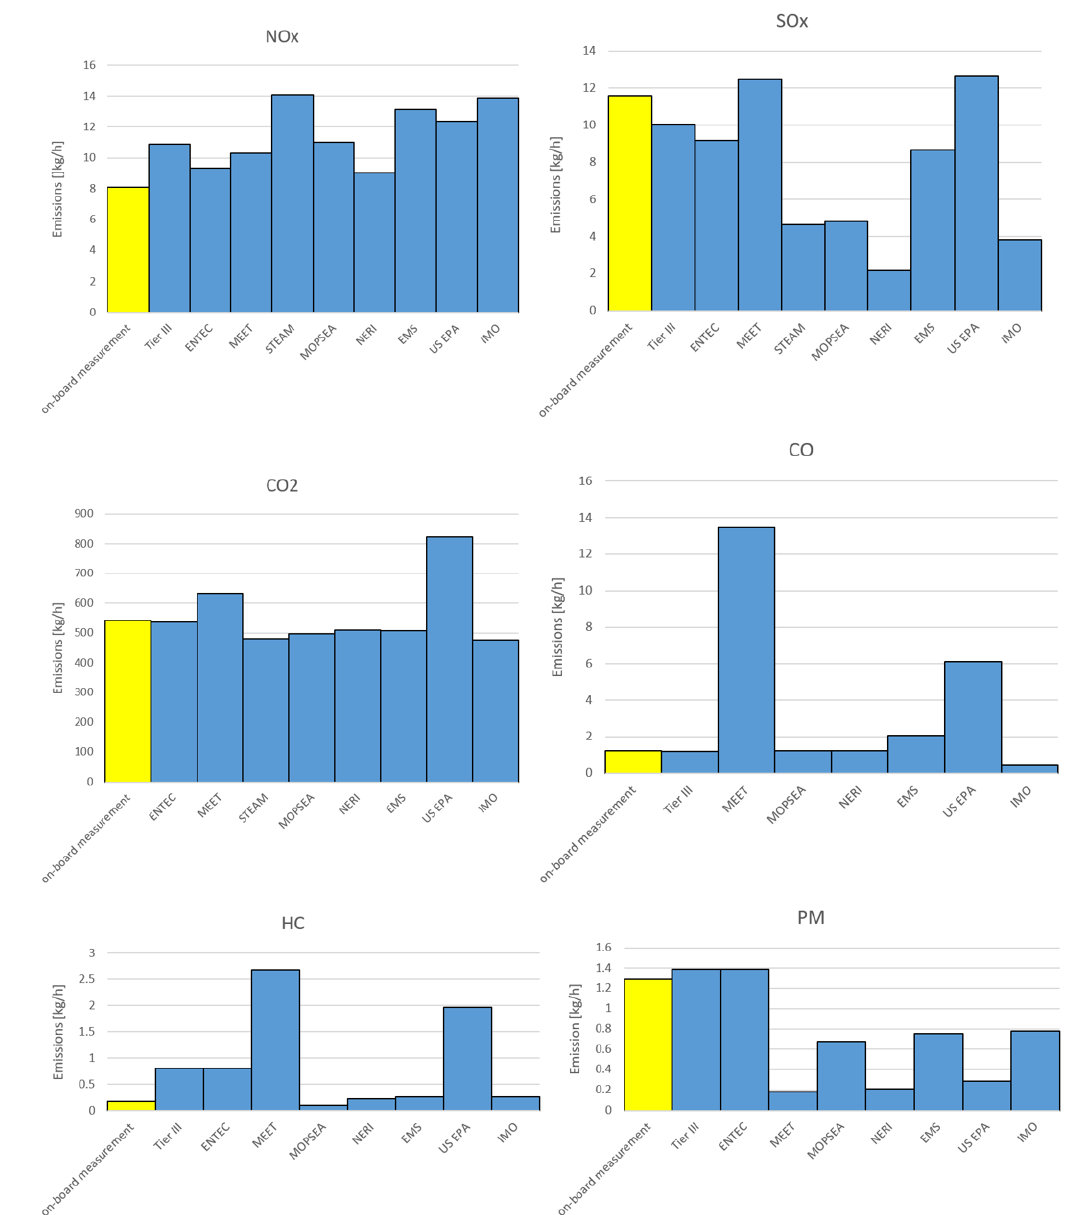
Figure 3: Combined hourly emission amounts’ measurement and inventory prediction at berth for the main engine plus the auxiliary